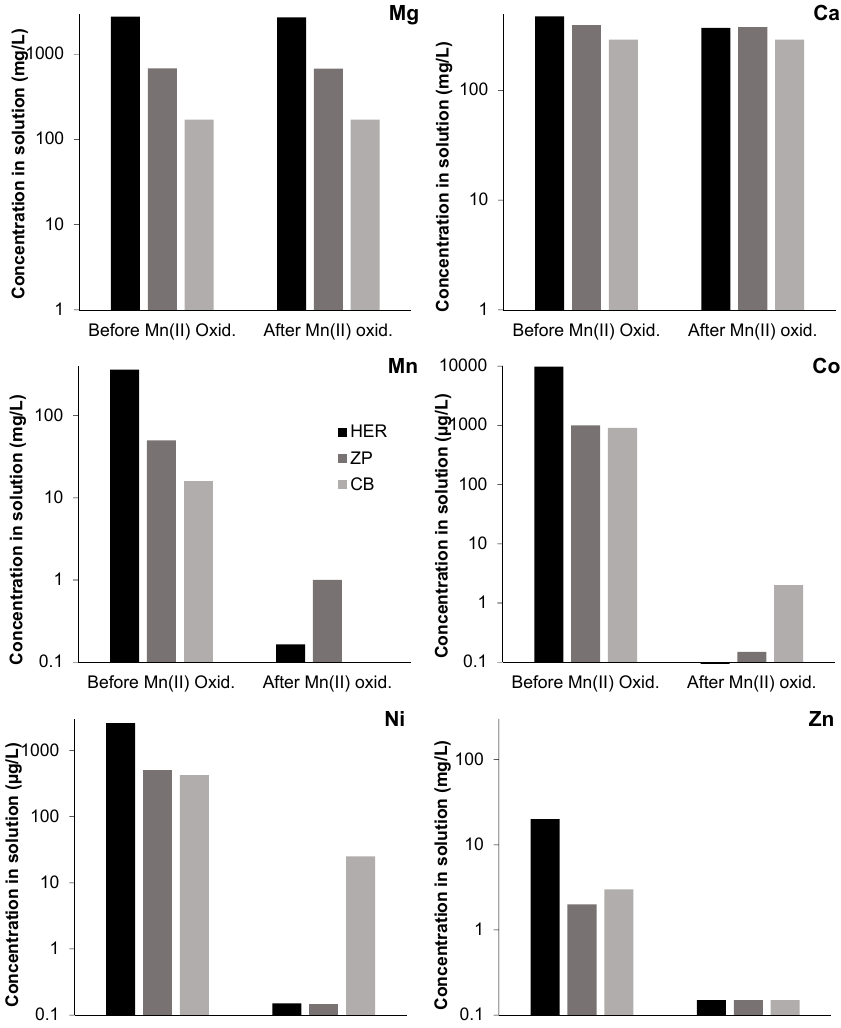
Figure 7. Metal concentration (Mg, Ca, Mn, Co, Ni, and Zn) measured in mine waters from di ff erent pit lakes (Guadiana-Herrer í as, HER; La Zarza, ZP; and Brunita, CB), before and after Mn(II) oxidation under continuous